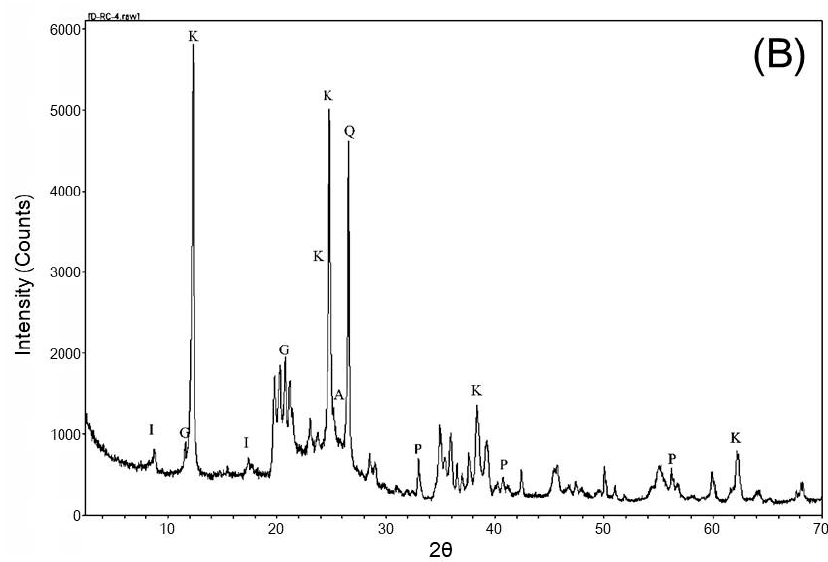
Figure 2. Powder XRD patterns of LTAs of the feed coals from the Xilaifeng and Damo power plants. ( A ) x-rc-12; ( B ) d-rc-4. K, kaolinite; P, pyrite; I, illite; Q, quartz; G, gypsum; B, boehmite; and A, anatase.